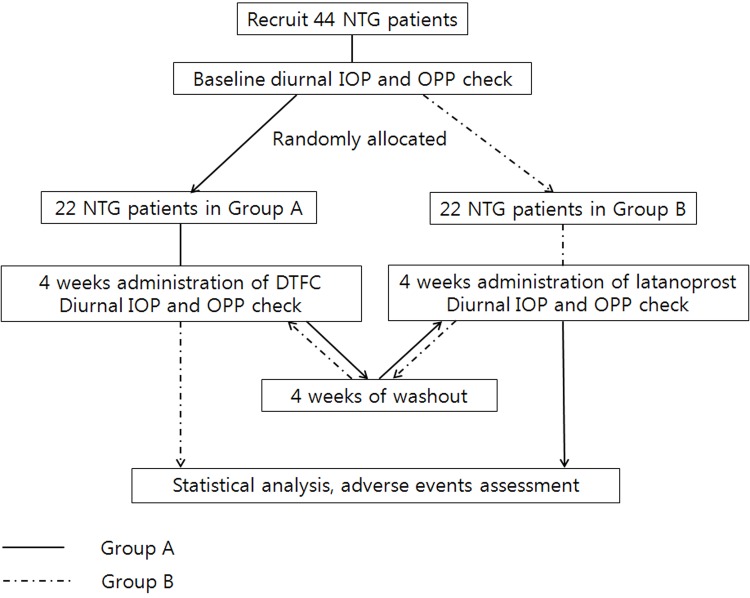
Consort diagram.NTG indicates normal tension glaucoma; IOP, intraocular pressure; OPP, ocular perfusion pressure; DTFC, dorzolamide/timolol fixed combination.